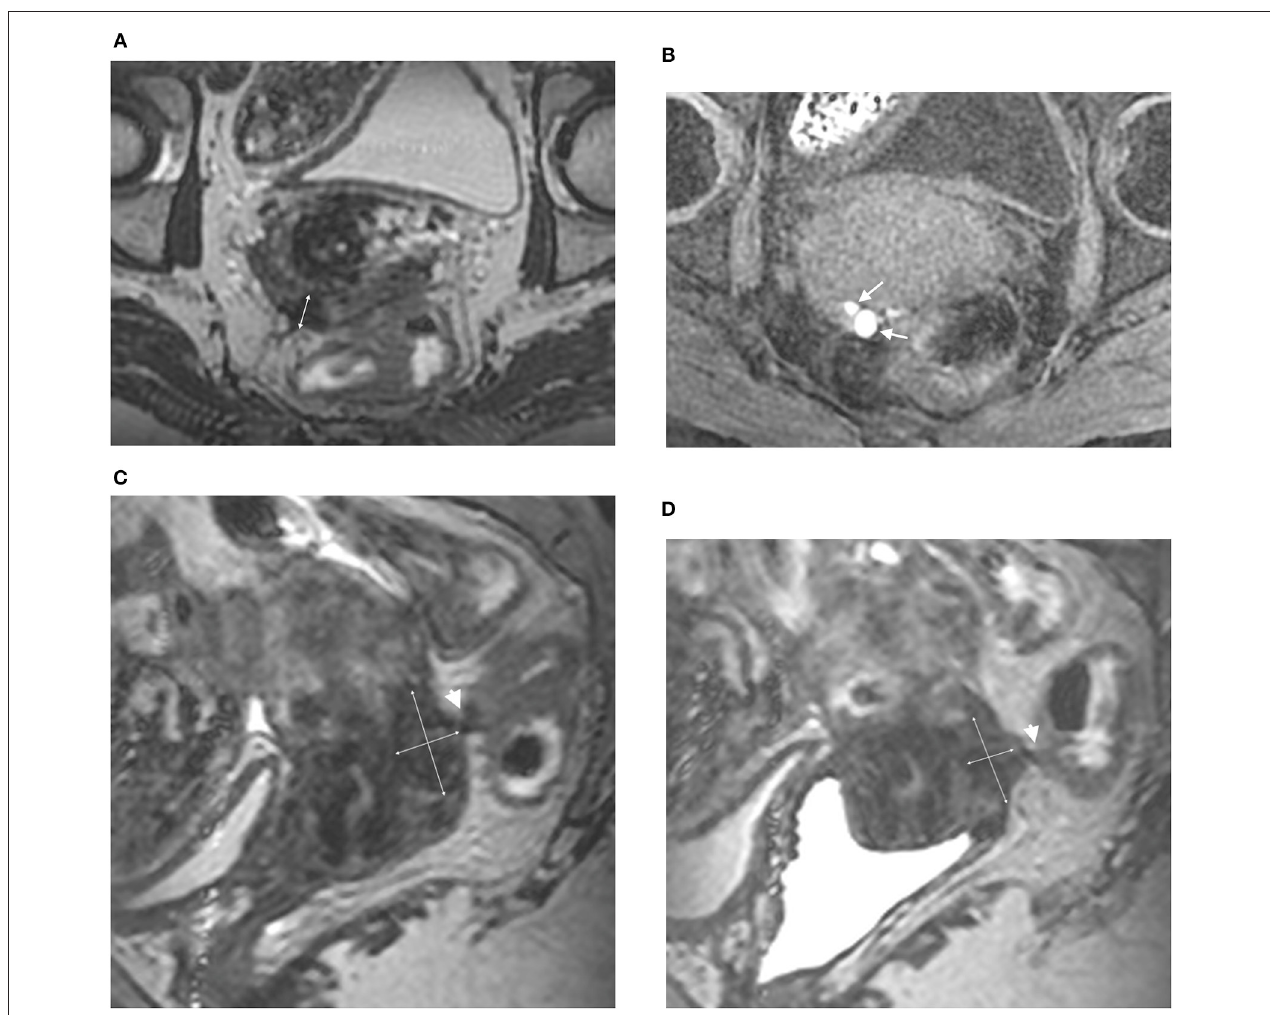
FIGURE 2 | Axial 3DT2 (A) and 3DT1FS (B) MR images in 44-year-old woman show thickening of posterior vaginal wall (double arrow) containing multiple spots (arrows) highly suggestive of vaginal endometriosis confirmed on surgery and histopathological examination. Sagittal 3DT2 (C) and 3DT2VO (D) MR images confirm extensive thickening of posterior vaginal wall (double arrows) associated with rectal involvement by DE (arrowhead). Note the absence of additional information provided by vaginal